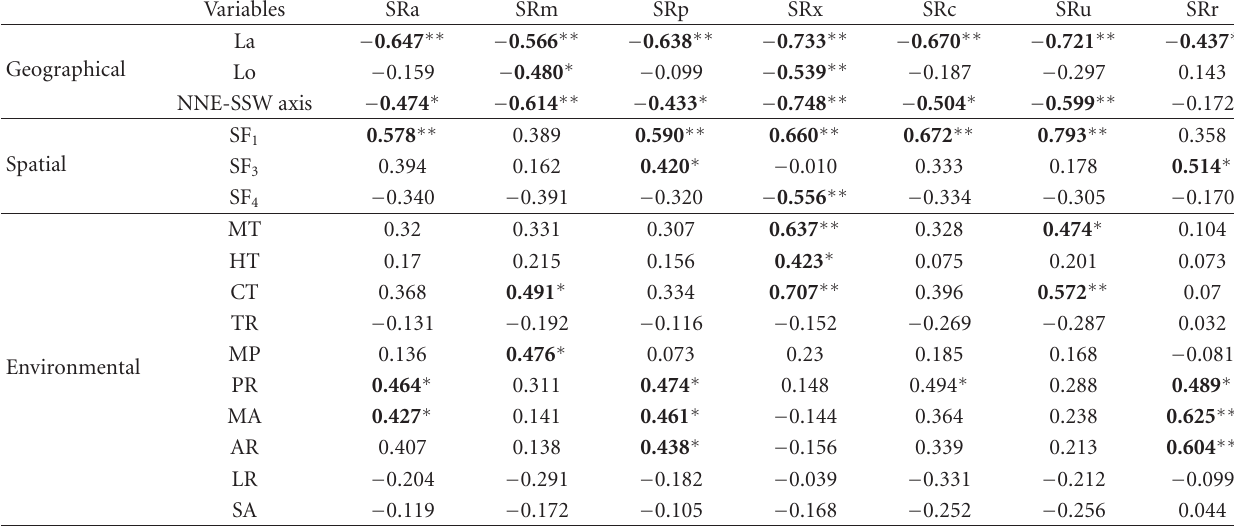
Table 3: Pearson’s correlation coe ffi cients between the species richness of each group of mammals and the geographical, spatial, and environmental variables used for analysing the geographical gradients in species richness.